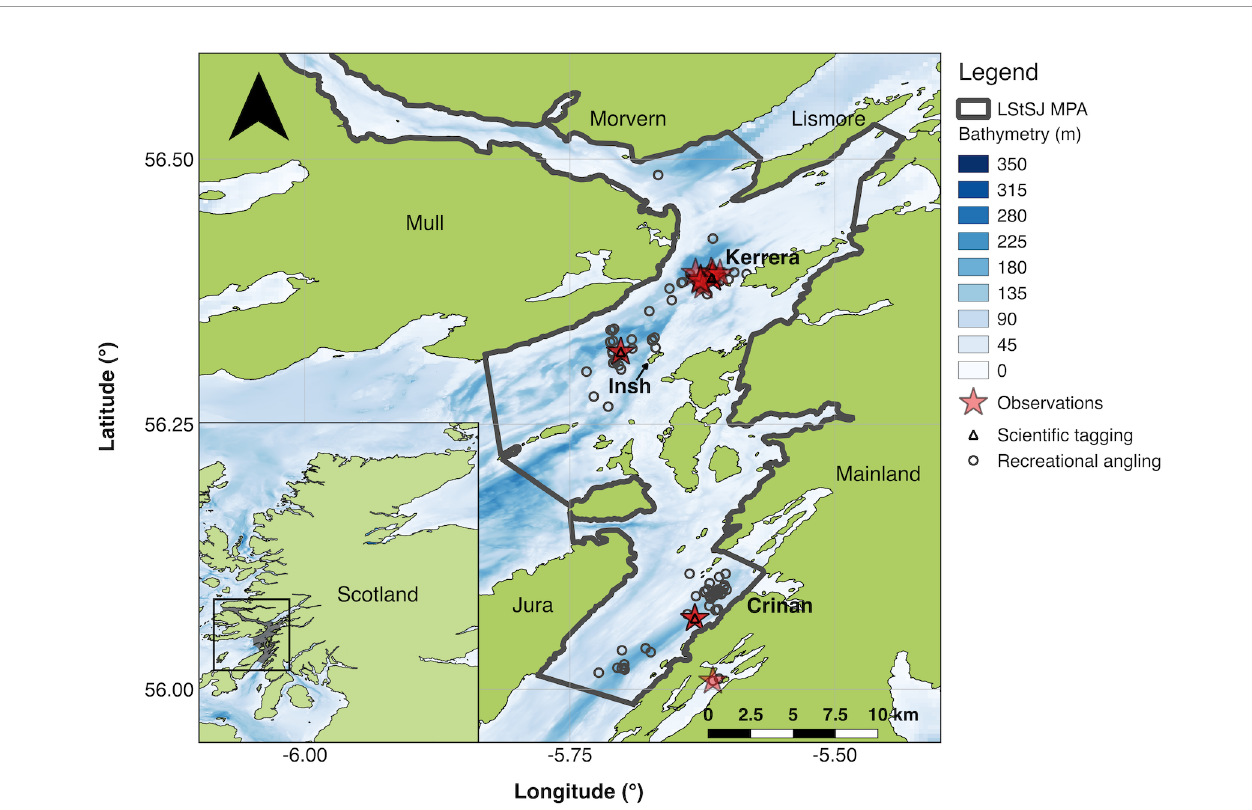
FIGURE 1 | The study site and catch-and-release records. In the inset, the location of the study site in Scotland is shown in grey and enclosed. In the main fi gure, the Loch Sunart to the Sound of Jura Marine Protected Area is shown. The three main angling sites (Kerrera, Insh and Crinan) are noted in bold. Points mark recreational angling and scienti fi c tagging events recorded in the capture-recapture (n = 1,166) and Movement Ecology of Flapper Skate archival (Star Oddi milli-TD) tagging (n = 45) databases, as described in Lavender et al. (2021a). Stars mark capture events associated with archival data used in this study (n = 26). The background shows the bathymetry (m) around Scotland at 15-arc resolution and the MPA at mixed 5 x 5 m and 15 arc second resolution, with high-resolution data from Howe et al. (2014) shown where available and lower resolution data from the General Bathymetric Chart of the Oceans (GEBCO Compilation Group, 2020) shown otherwise. Coastline data were sourced from the Database of Global Administrative Areas (Global Administrative Areas,